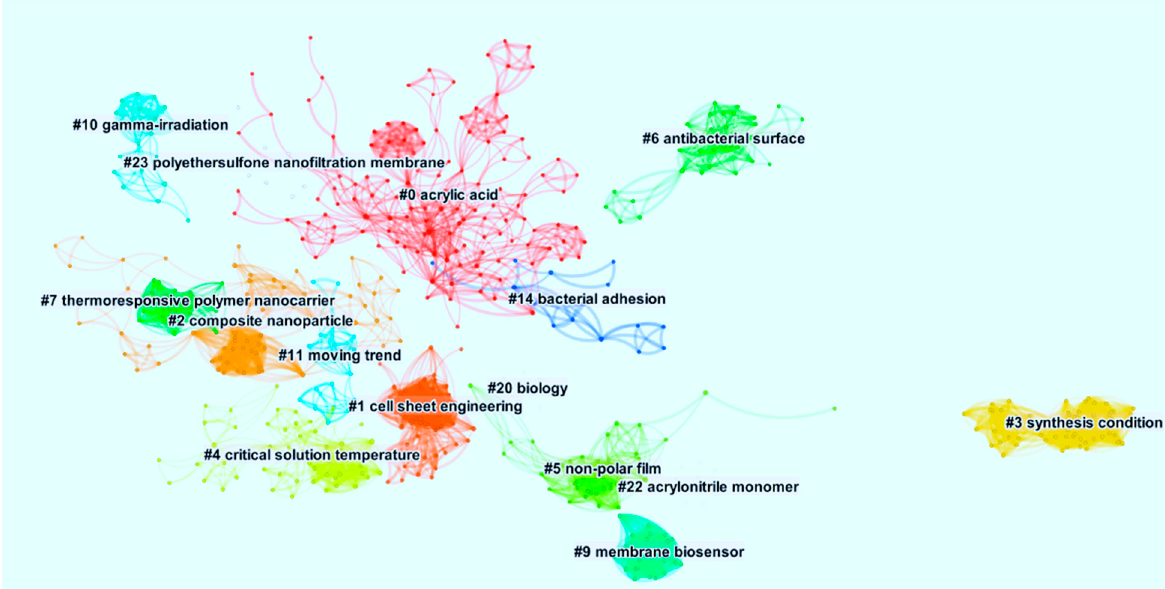
Figure 9. Co-occurrence of clustered keywords network of publications on FPBMs prepared by RIGC. (Obtained by VOSViewer).